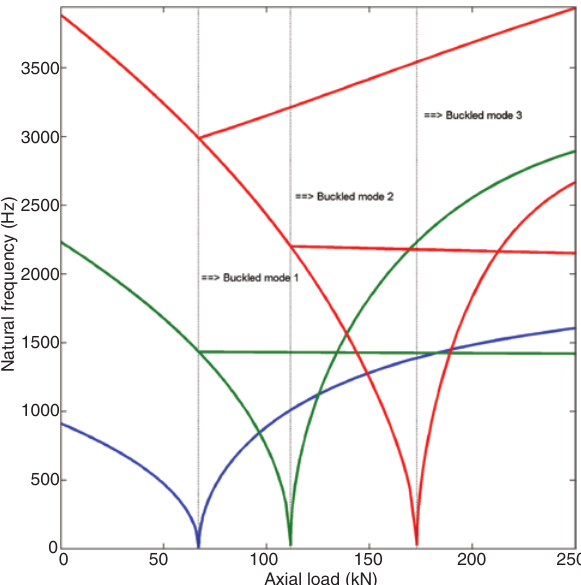
Figure 6 Variation of the natural frequency around the first three buckled configurations with the applied axial load for a CC beam with unidirectional lay-up.